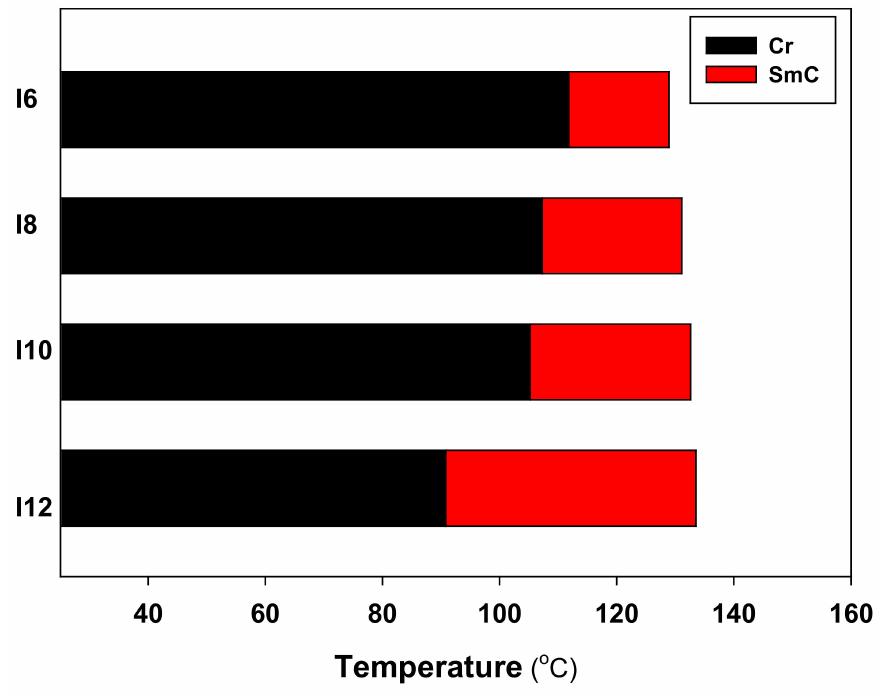
Figure 3. DSC graphical transitions of studied derivatives, In